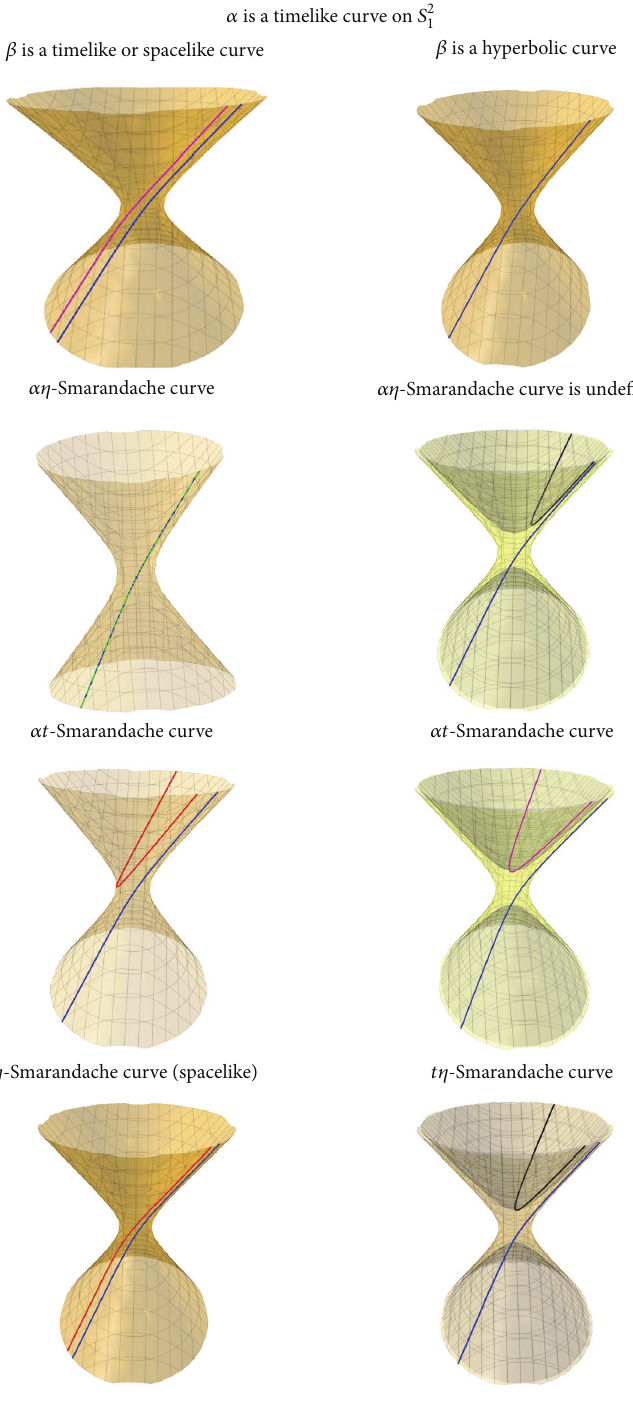
Figure 1: Smarandache curves of a timelike curve 𝛼